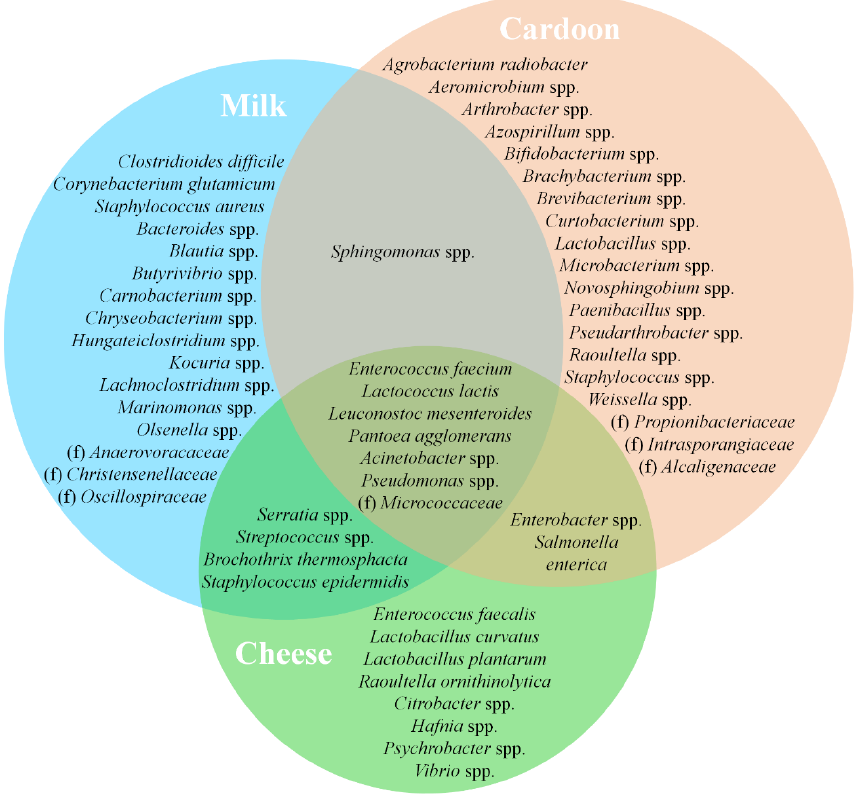
Figure 9. Venn diagram representing shared core taxa of bacteria between raw ewes’ milk (blue area), cardoon (red area) and Serra da Estrela cheese (green area) matrices. f denotes identified bacterial families without taxonomic attribution to genus and/or species.